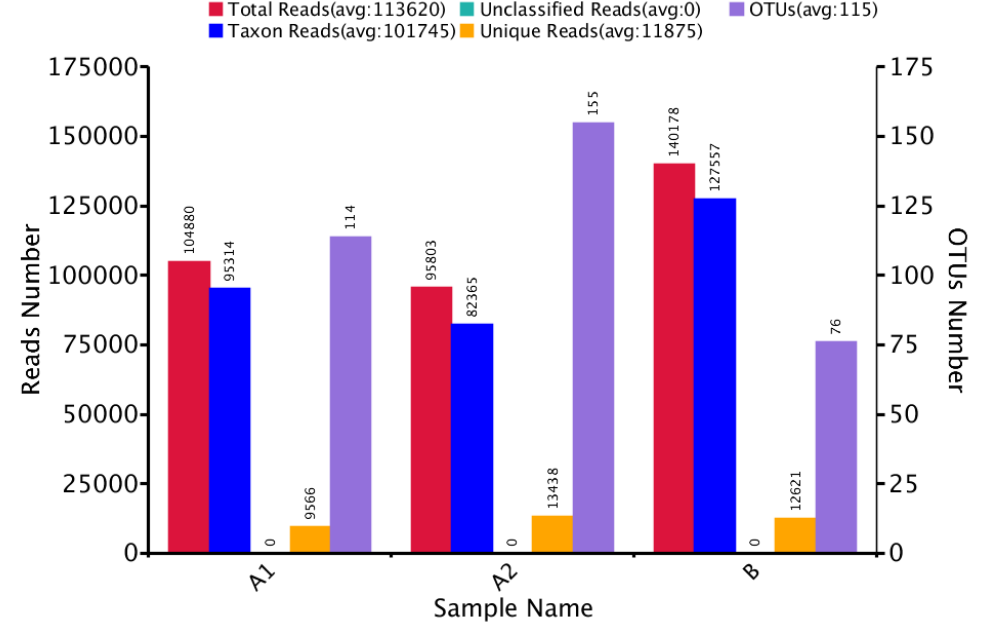
Figure 1. Analysis of annotation and OTUs number of each sample. Total reads are related to the number of effective reads, while taxon reads are related to annotated reads. Unique reads refer to the number of reads with a frequency of 1 and only occur in one sample.